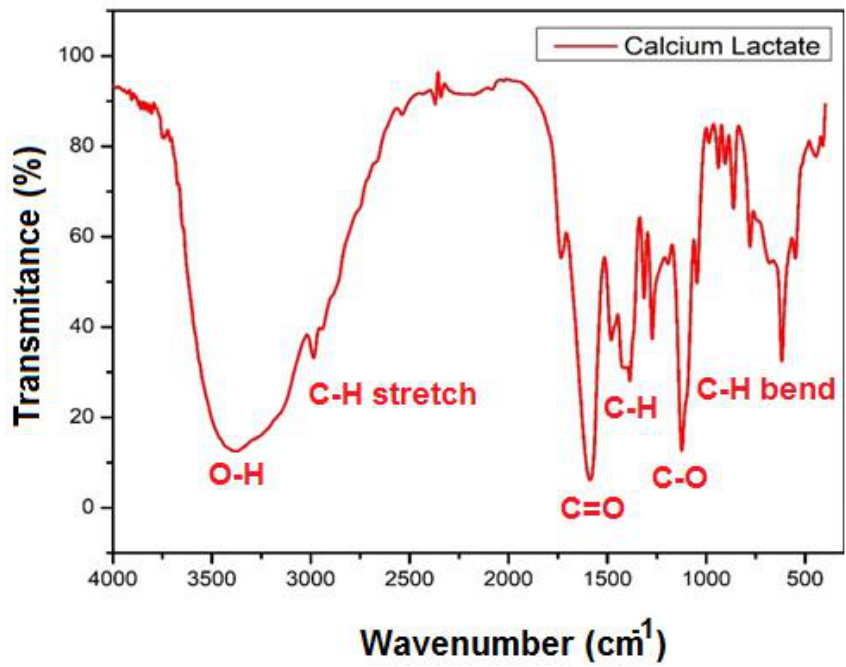
Figure 3. FTIR analysis of the synthesized calcium lactate powder.